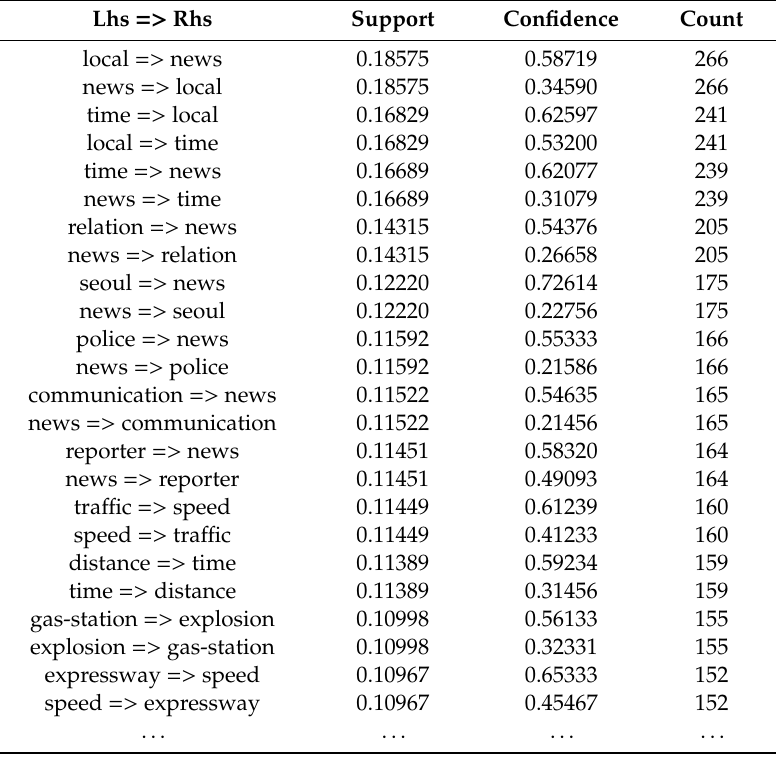
Table 5. Association Rules based on the Apriori